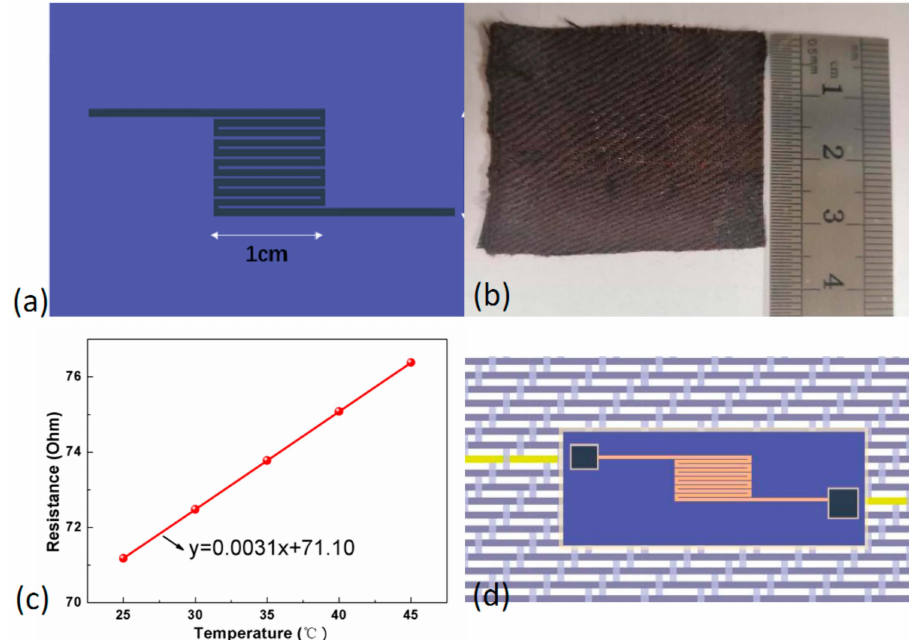
Figure 5. ( a ) Schematic diagram of the fabric temperature sensor; ( b ) Picture of the fabric temperature sensor; ( c ) Typical resistance– temperature curve of the fabric sensor; and ( d ) Schematic diagram of the permanent connection between the conductive track in the FCB and the sensor